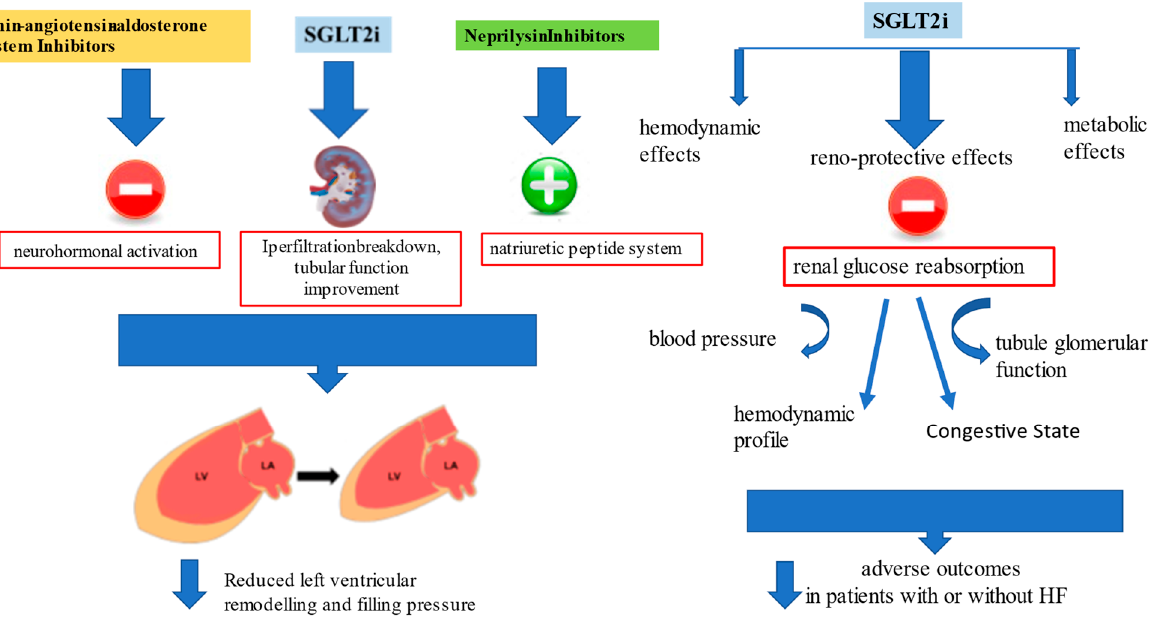
Figure 2. Renin-angiotensin-aldosterone system inhibitors (RAASi) and neprylisin antagonist actions on cardiac remodeling and progressive dysfunction, and additional metabolic, vascular and renal protective effects of sodium-glucose transporters-2 inhibitors (SGLT2i) beyond functional cardiac status improved outcome in both HFrEF and